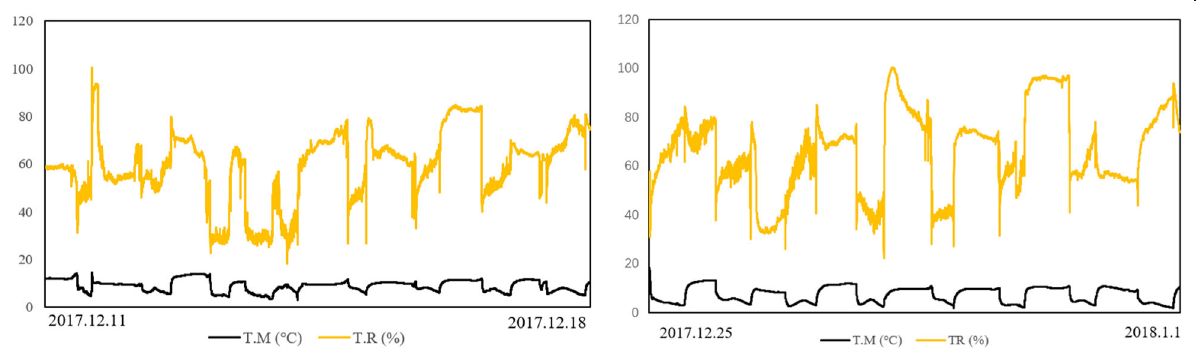
Fig. 9 Temperature (black line) and humidity (yellow line) across the two biological replicates of the natural low-temperature treatment. The first replicate was treated from 11 December 2017 to 18 December2017, and the second biological replicate was treated from 25 December 2017 to 1 January 2018. Shown is the total across 8 d. The black line represents the change in natural low temperature. In the daytime, the natural temperature was higher than the temperature at night, but the highest temperature was only 14.5°C, and the lowest temperature was only 1.8°C